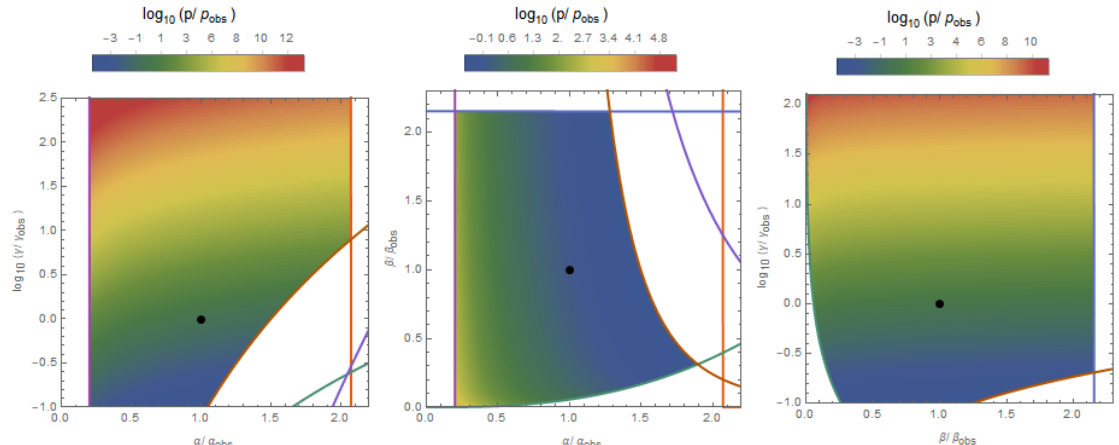
Figure 5. Display of when runaway migration takes hold, in the α – γ , α – β , and β – γ subplanes. The teal line is for type I migration, the orange line is for type II, and the purple line is when the mass of the fastest migrating body is equal to the terrestrial mass. All curves have been normalized so the timescales in our universe are five times larger than the critical